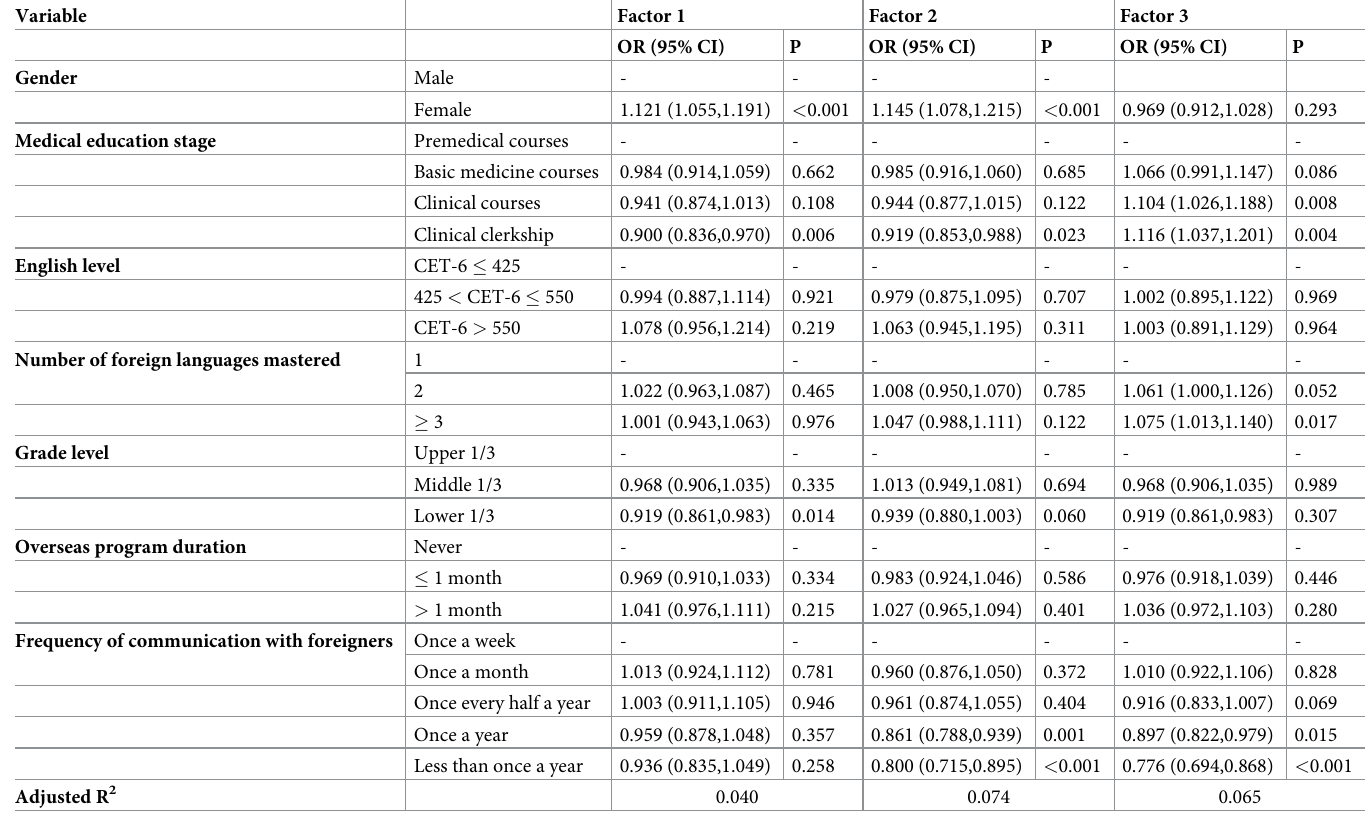
Abbreviations: OR, odds ratio; CI, confidence interval. For other abbreviations, see the previous table. Data are presented as mean (SD) or median (25–75% quartile).